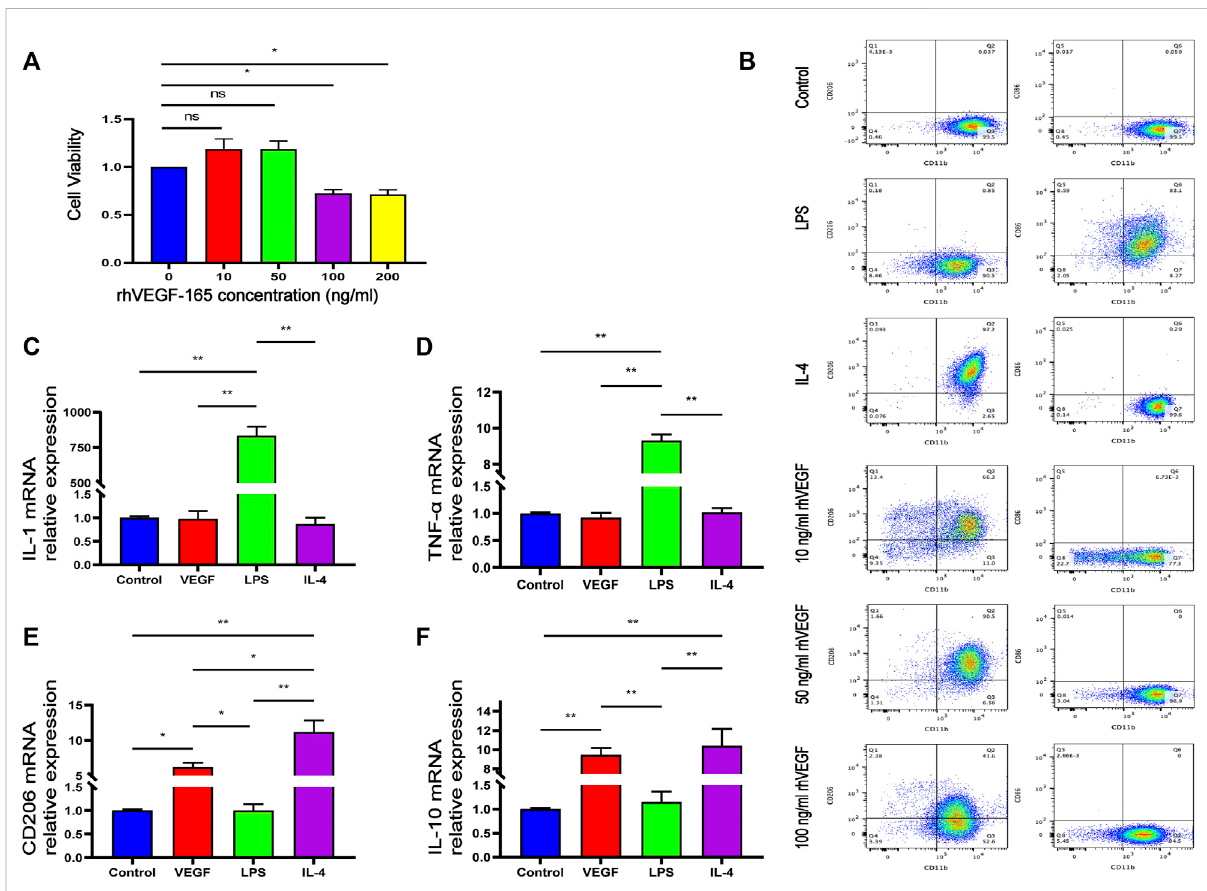
FIGURE 4 Viability of RAW264.7 macrophages after 24 h of incubation with different concentrations of rhVEGF-165 (A) . The proportion of M1 to M2 macrophages in RAW264.7 cells in each group (B) . The expression levels of M1 or M2 macrophage markers in RAW264.7 cells in each group (C,D,E and F) . * p < 0.05. ** p < 0.01. ns represents no signi fi cant